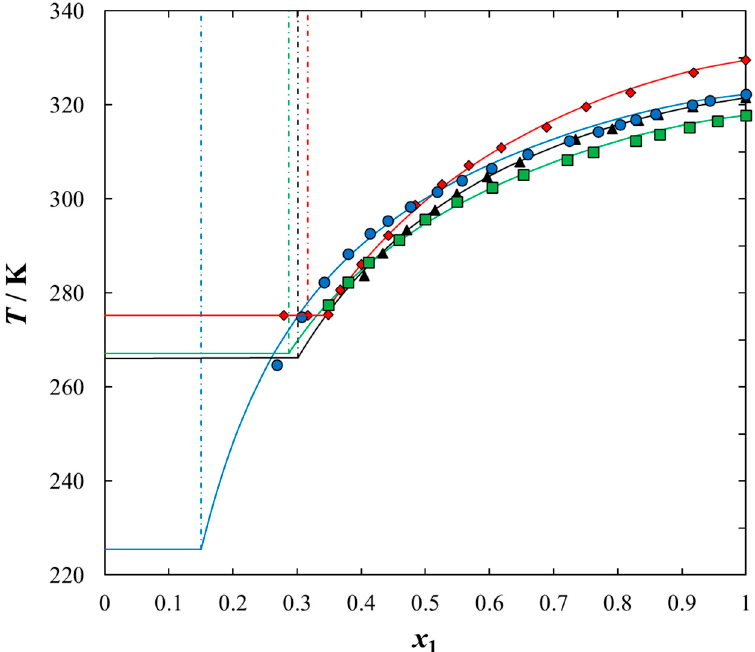
Figure 3. Experimental and calculated (solid + liquid), SLE and (liquid + liquid), LLE phase equilibrium data for {IL (1) + benzothiophene (2)} binary system: ♦ , [BQuin][NTf 2 ]; ▲ , [BiQuin][NTf 2 ]; ■ , [HQuin][NTf 2 ]; ● , [OQuin][NTf 2 ]. Points show the experimental data; solid line is the correlation of NRTL model with parameters given in Table 5; dash-dotted line is the experimental binodal curve.